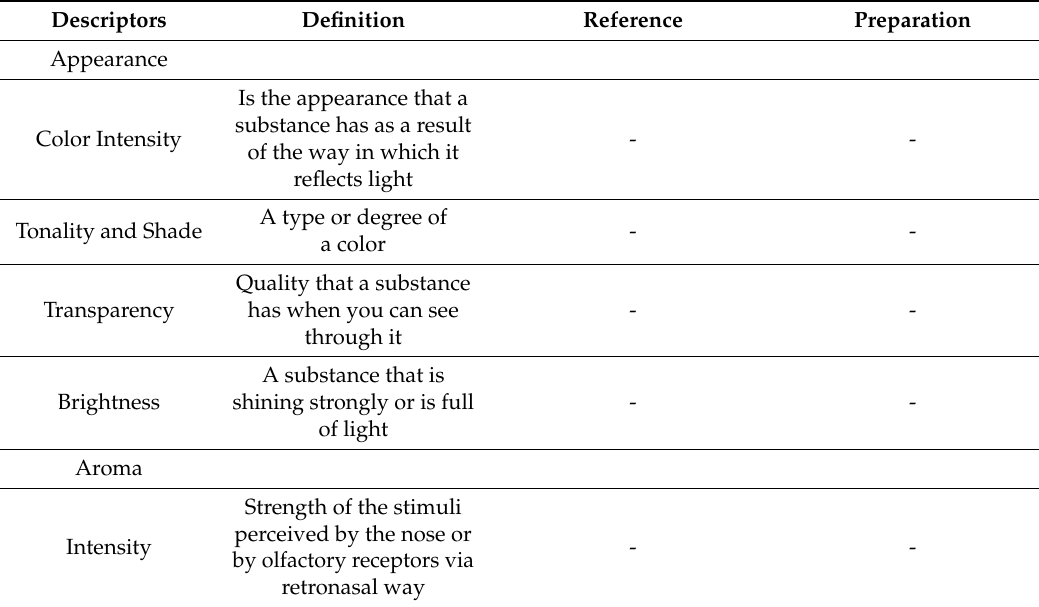
Table 3. List of final attributes definitions, references, and references’ preparation to train the